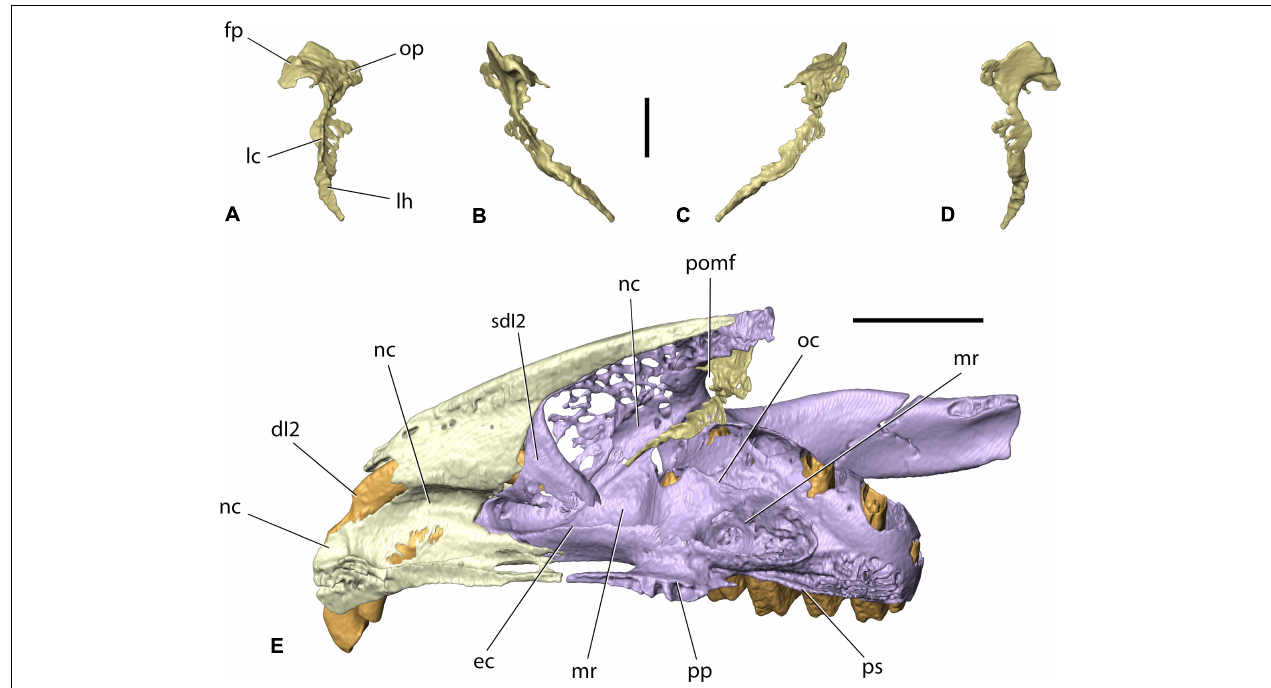
FIGURE 6 | Right lacrimal of Palaeolagus haydeni (FMNH PM9476) in (A) anterior, (B) lateral, (C) medial, and (D) posterior views. Note the incompleteness of the facial process and orbital plate. (E) Right premaxilla (light yellow), lacrimal (gold) and maxilla-zygomatic complex (light purple) in dorsomedial view, highlighting the position of the nasolacrimal canal. Teeth marked with orange. fp, facial process; dI2, anterior upper incisor; lc, lacrimal crest; lh, lacrimal hamulus; mr, maxillary recess (sinus); nc, nasolacrimal canal; oc, orbital crest; op, orbital plate; pomf, ‘pars orbitalis’ of maxillary fenestra; pp, palatine process; ps, palatine shelf; sdI2, sheath for dI2. Scale bar in (A–D) = 2 mm; scale bar in (E) = 5